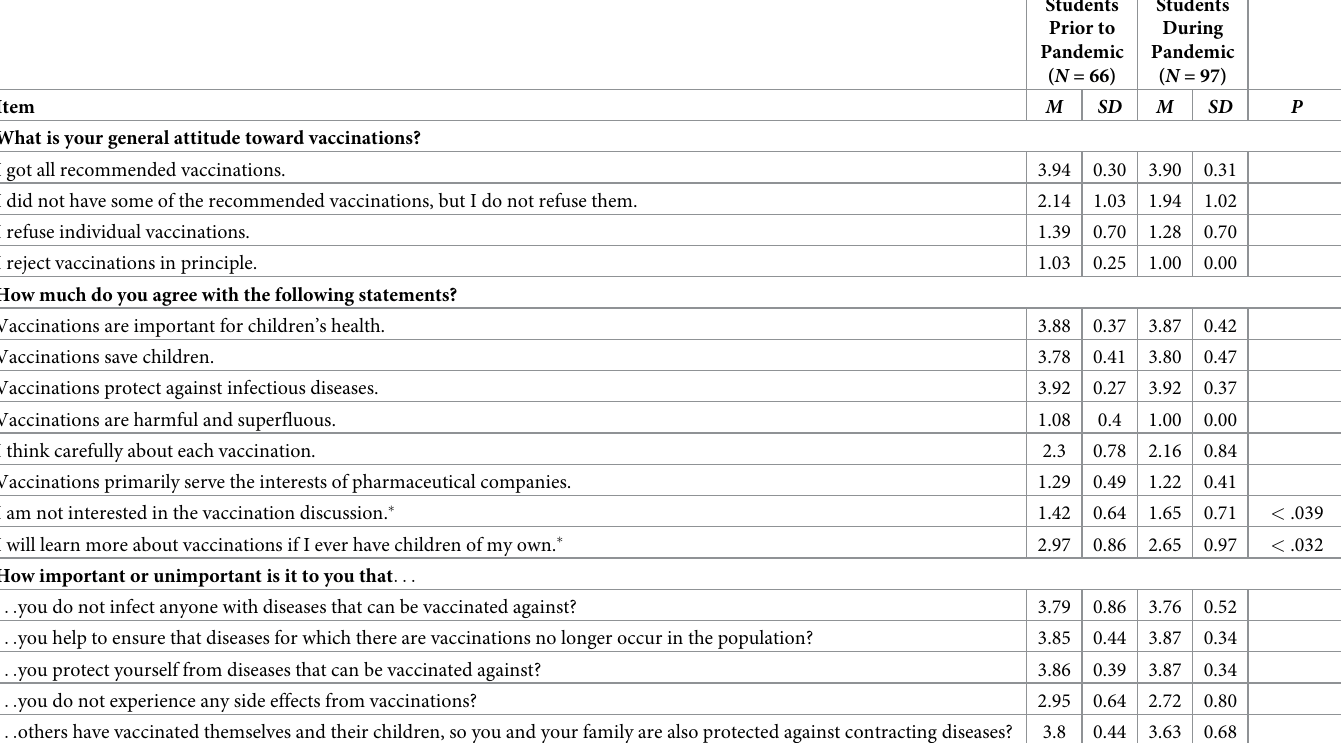
Table 1. Attitudes toward